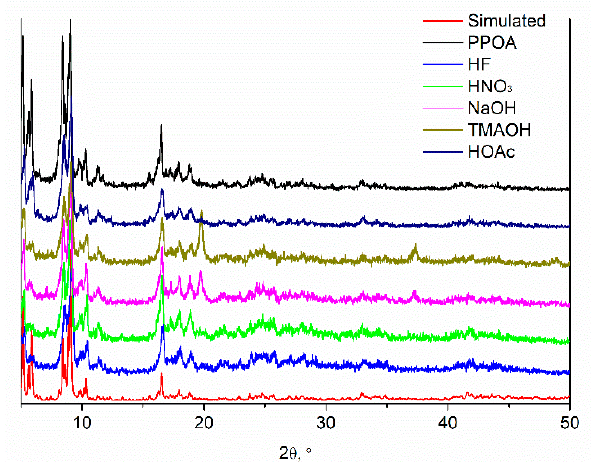
Figure 3. The powder X-ray diffraction (PXRD) diffractograms of MIL-101(Cr)s compared with simulated pattern.